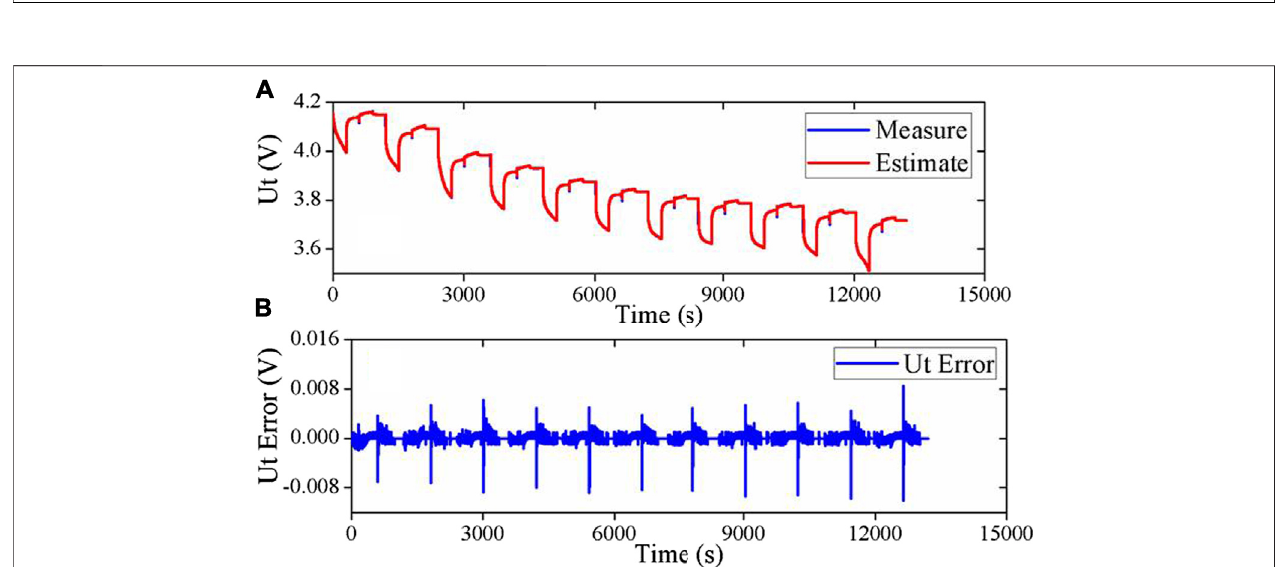
FIGURE 5 | Results of parameter identi fi cation. (A) R0; (B) Rp; (C) Cp.